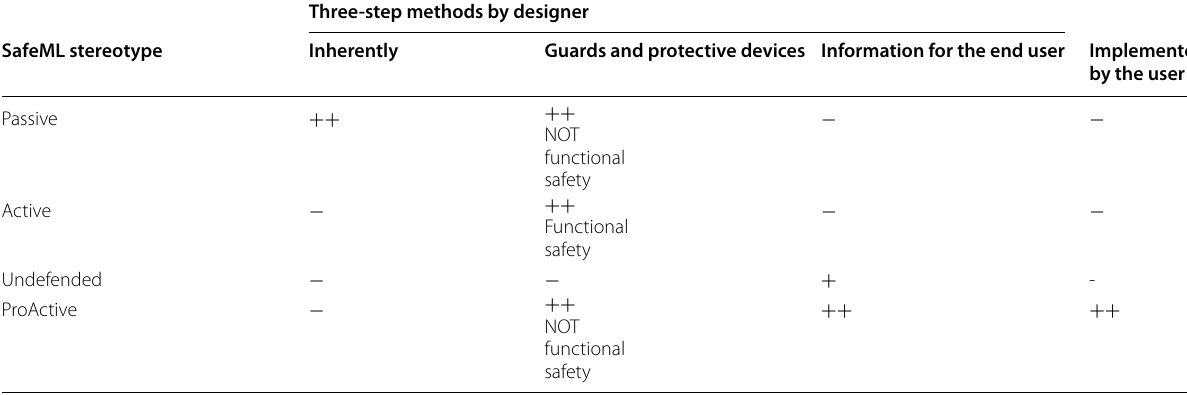
Table 3 SafeML stereotypes and risk reduction measures Three-step methods by